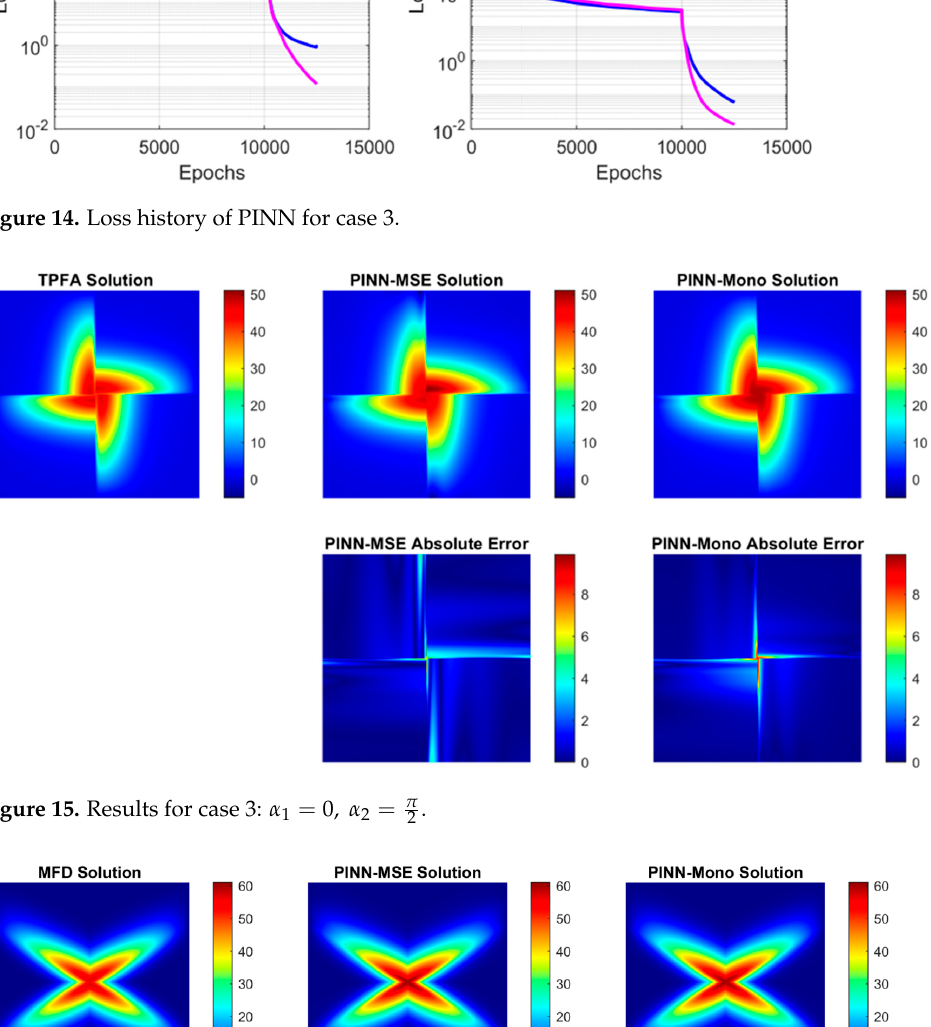
. (cid:2870) . . (cid:2870) 2